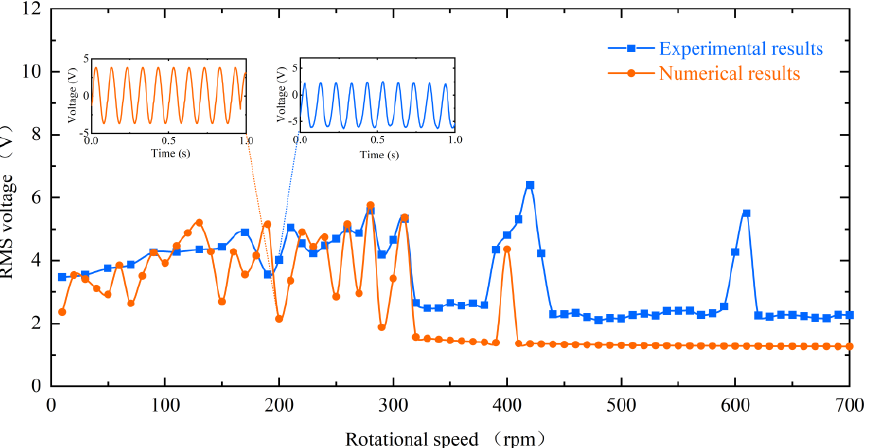
Figure 16. Comparison of simulation results and experimental results of RMS voltage for inverse beams at 10 mm magnet spacing.